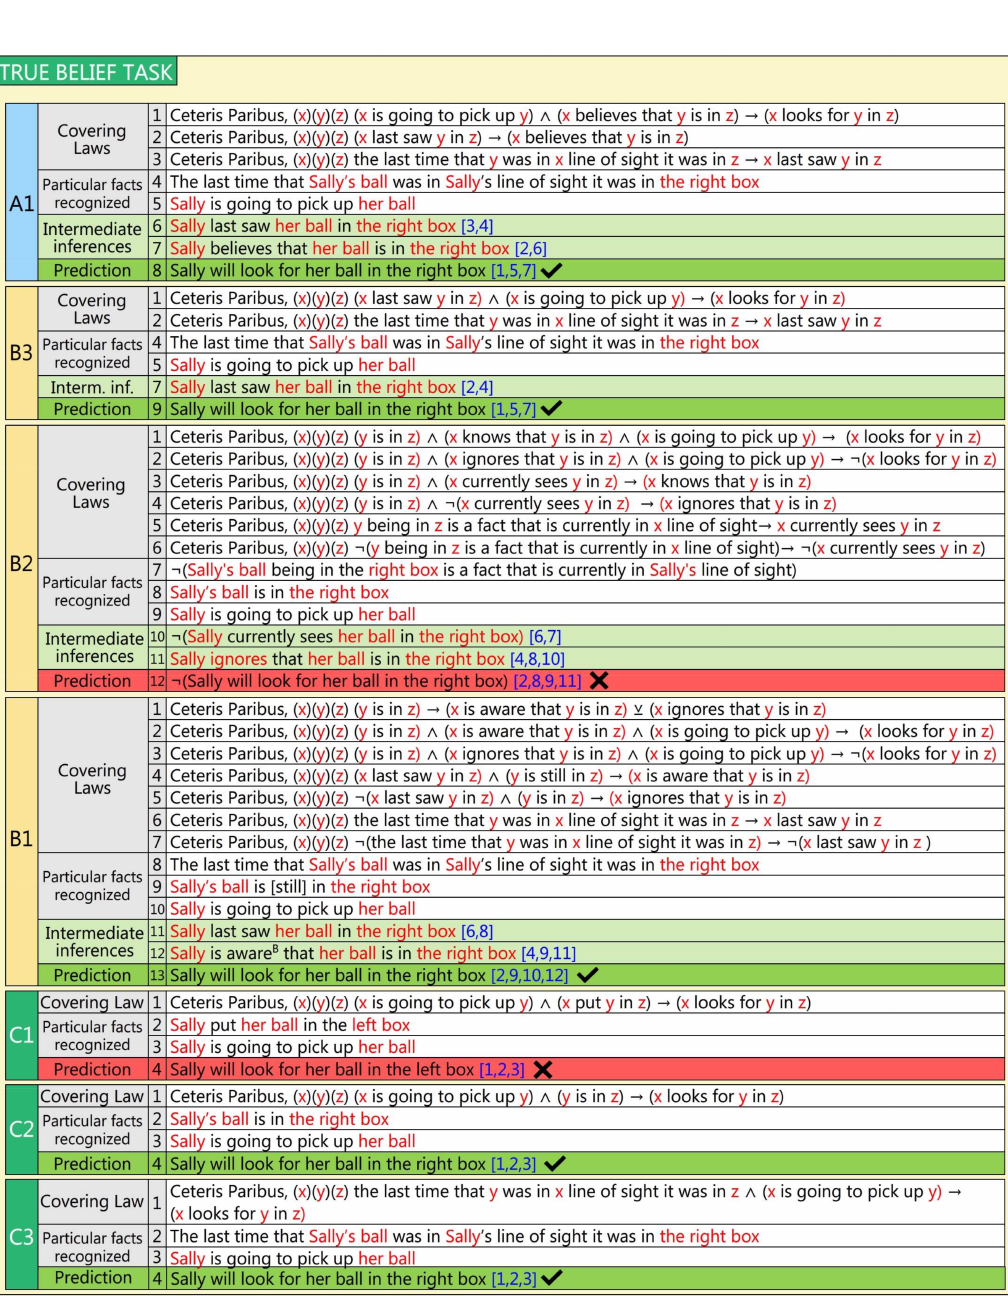
Figure 5. Semi-formalizations of the inferences in the true belief